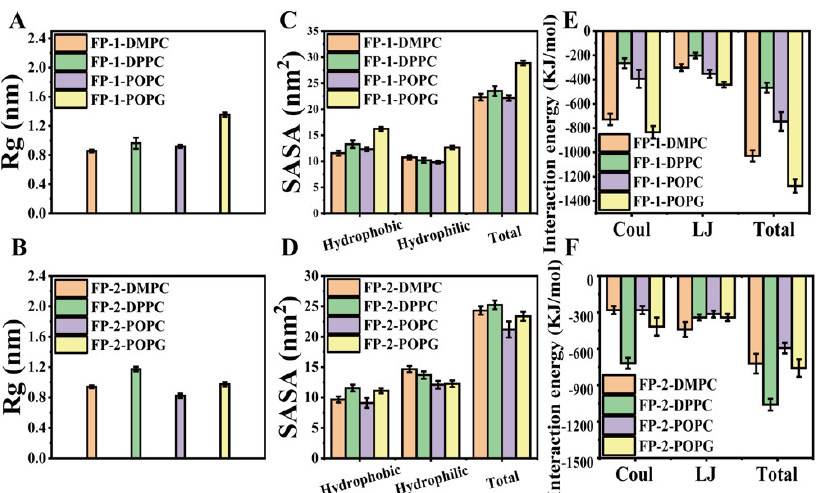
Figure 5. Analysis of the simulation process between the functional peptides and the lipid membrane at equilibrium performed in the last 25 ns of the simulation (t = 475–500 ns). ( A , B ) The radius of gyration average values for the functional peptides in different lipid membranes. ( C , D ) The solvent accessible surface area average amounts for functional peptides in different lipid membranes. ( E , F ) Decomposition of the total interaction (kJ/mol) between the functional peptides and different lipid membranes, in terms of the electrostatic components (Coulomb) and van der Waals (LJ). Error bars denote standard deviation (s.d.). Table 1. Measured dynamic, structural, and energetic properties from atomic-resolution simula- tions of the functional peptides a .